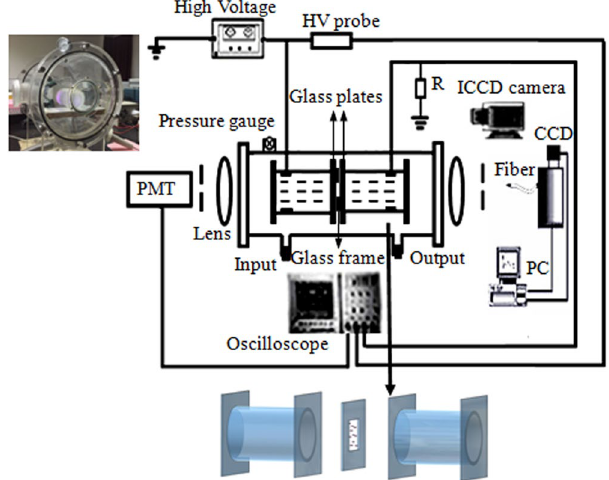
Figure 8. Schematic diagram of the experimental